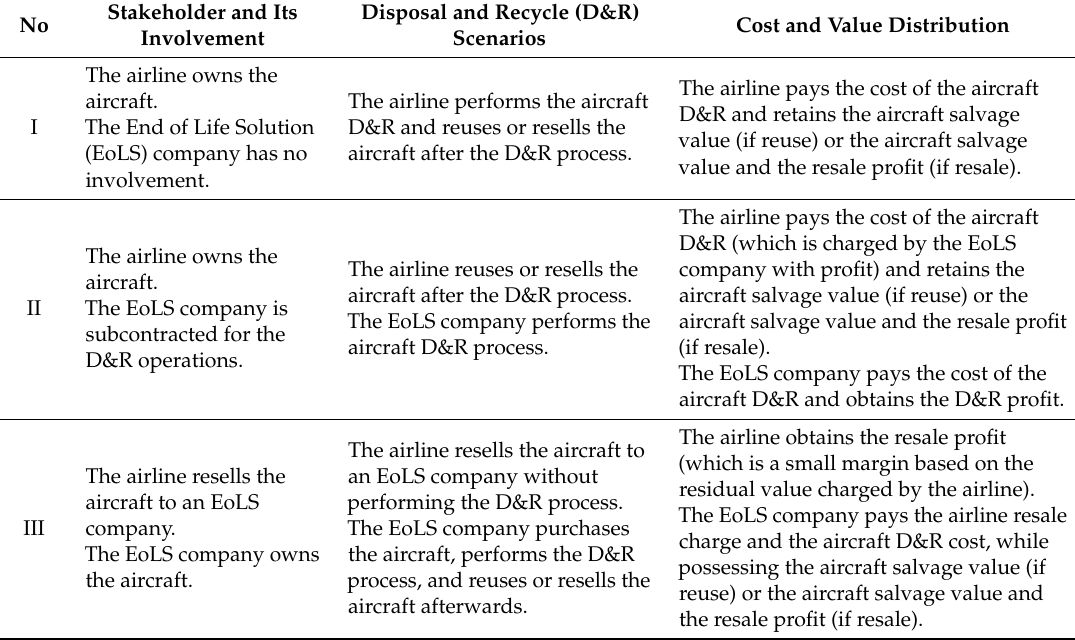
Table 1. Stakeholders and relevant